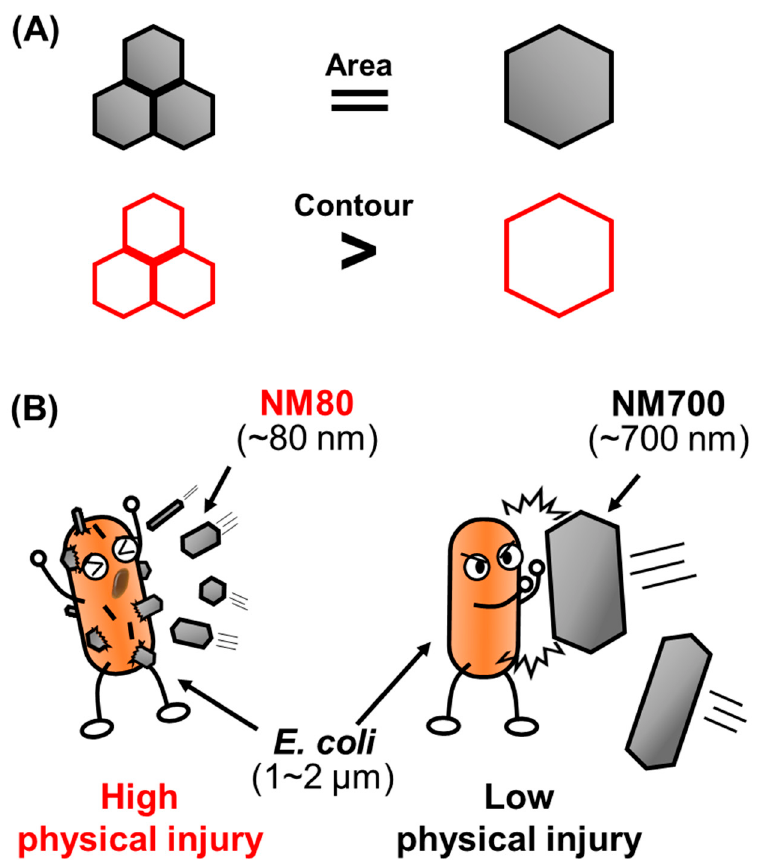
Figure 7. Illustration of the plausible mechanism of action of magnesium hydroxide nanoparticles against E. coli . ( A ) Magnesium hydroxide nanoparticles are assumed to be regular hexagons. Com- parison of the contour of several smaller sizes with that of one large particle with the same area; (top, gray); the total contour length will be longer for smaller areas (bottom, red). ( B ) Image showing a comparison of the physical killing of E. coli by NM80 and NM700.